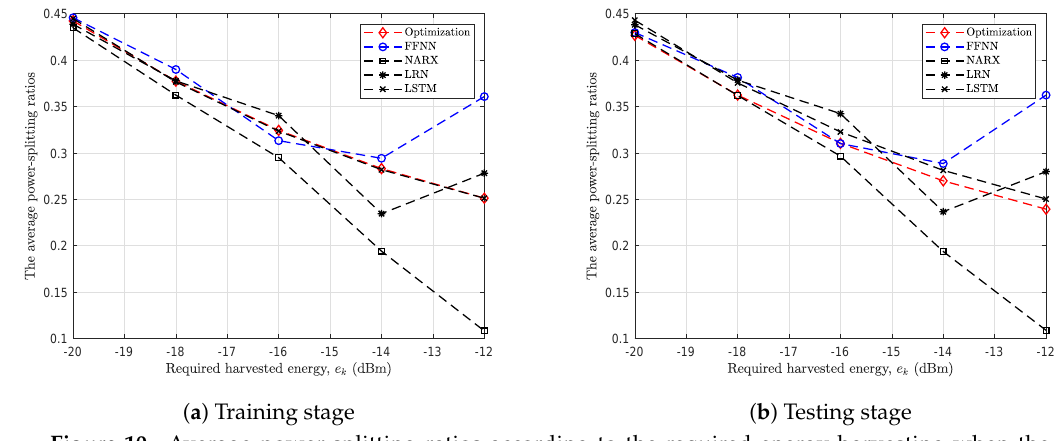
Figure 10. Average power-splitting ratios according to the required energy harvesting when the required SINR is given by 2 dB ( γ k = 2